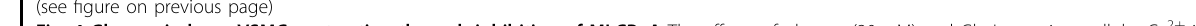
Fig. 4 Glucose induces VSMC contraction through inhibition of MLCP. A The effects of glucose (30 mM) and Glu-Ins on intracellular Ca 2 + in VSMCs. n = 5. B The effects of FCCP, nigericin, CH 3 COO - and NH 4 + on intracellular Ca 2 + in VSMCs. n = 5. C The effects of Glu-Ins on vascular constriction in isolated aortas preincubated with either thapsigargin (TG) or BAPTA-AM. n = 5. D The effects of glucose (30 mM) on MLC phosphorylation in cultured VSMCs preincubated with either TG or BAPTA-AM. n = 5. E The effects of glucose (30 mM) on MLC phosphorylation in cultured VSMCs preincubated with either Y27632 or Fasudil. n = 5. F Glucose (30 mM) increased phosphorylation of MYPT1 and CPI-17 in cultured VSMCs. n = 5. G Nigericin and NH 4 + increased MYPT1 phosphorylation and FCCP and CH 3 CHOO - decreased MYPT1 phosphorylation in cultured VSMCs. n = 5. H Glucose (30 mM) showed little effects on both RhoA expression and activity in cultured VSMCs. n = 4. I Knockdown of RhoA did not block the effects of glucose (30 mM) on phosphorylation of MLC and MYPT1 in cultured VSMCs. n = 5. J Knockdown of MYPT1 impaired the effects of glucose (30 mM) on MLC phosphorylation in cultured VSMCs. n = 5. K The effects of TEMPO, mitoTEMPO, and α -CCA pretreatments on glucose in fl ux-induced phosphorylation of MYPT1 and MLC in VSMCs. n = 5. Error bars represent SEM. * P < 0.05. ** P <